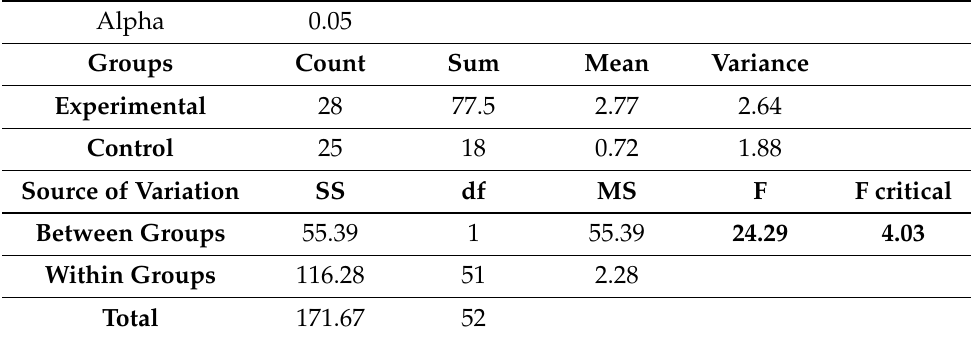
Table 9. ANOVA (single factor) for Programming block achievement tests